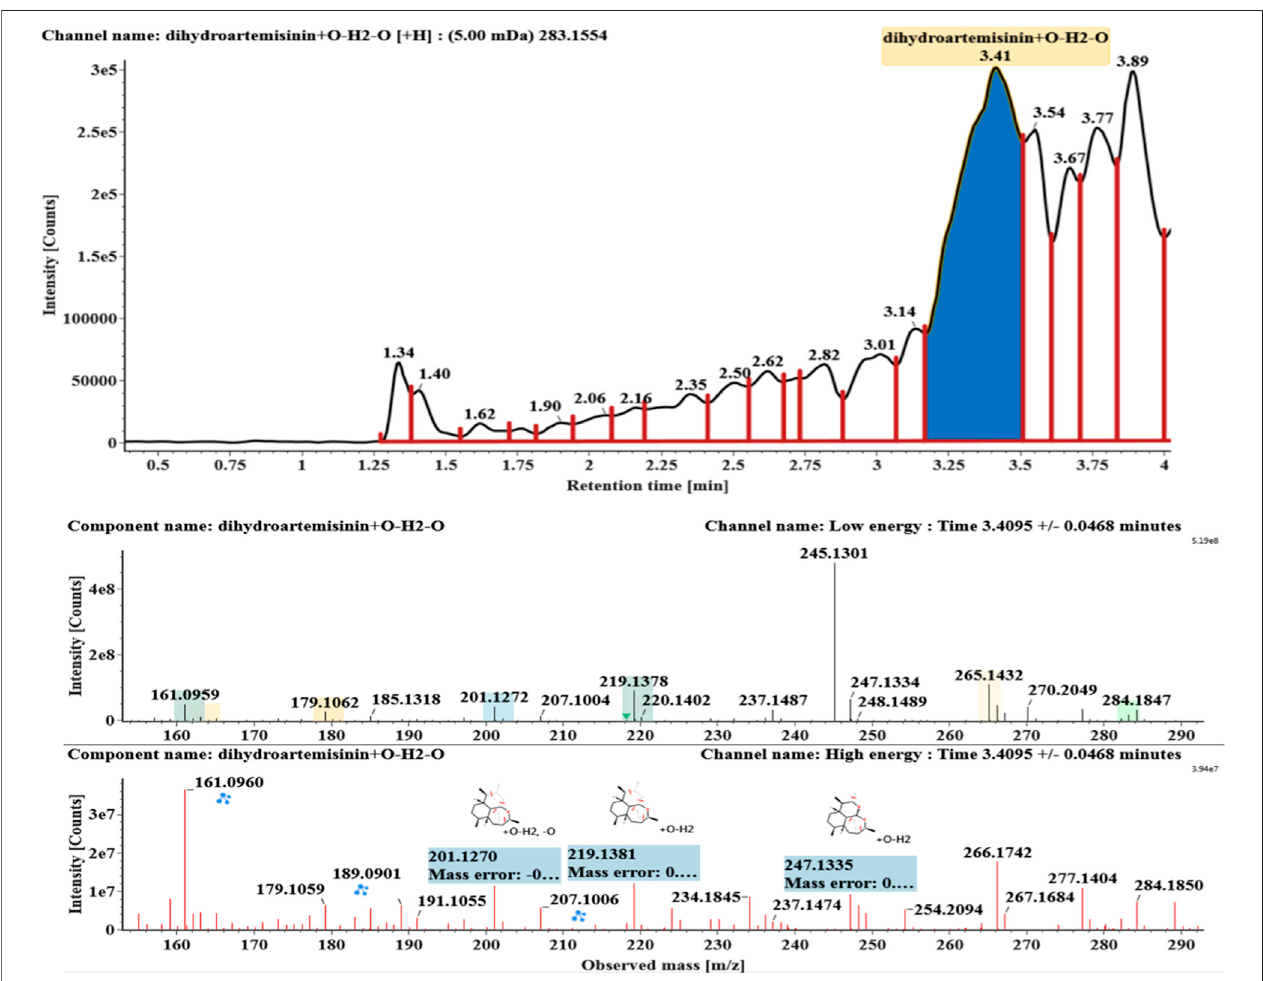
FIGURE 7 | Extracted ion chromatograms and mass spectrometry (MS E ) spectra of M6 .